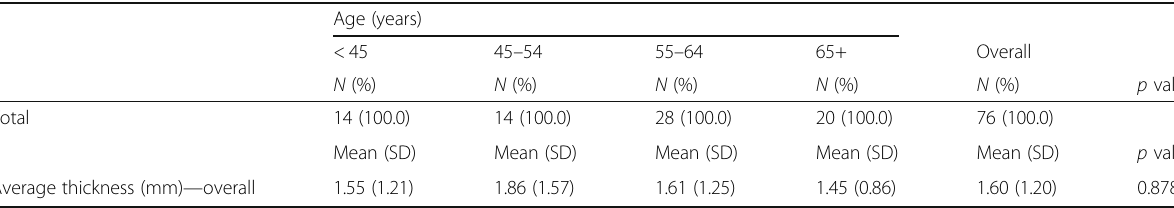
Table 2 Average thickness by age group